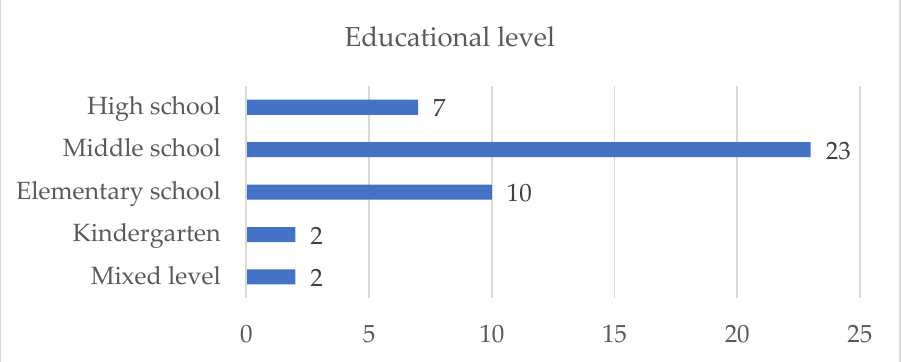
Figure 2. The educational level of design thinking papers.